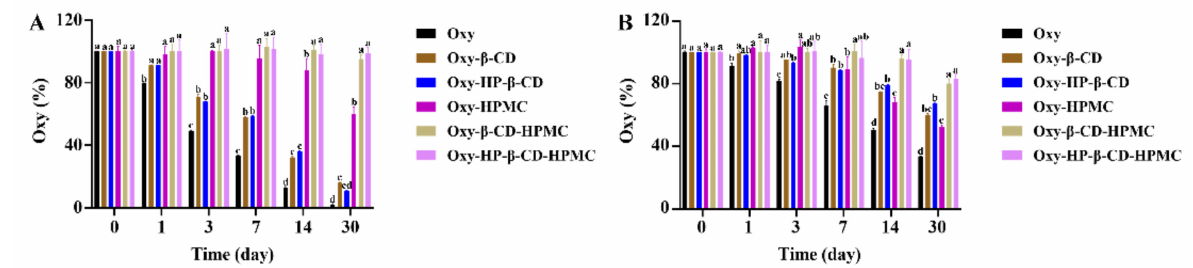
Figure 7. The percentage of remaining Oxy (both trans - and cis -forms) in Oxy, Oxy–HPMC, Oxy–CD, and Oxy–CD–HPMC solutions during 30 days of storage at 5 ◦ C without light was recorded by monitoring Oxy content with HPLC at a certain time interval ( n = 3, if no error bars are displayed, errors were smaller than symbols). Data were presented as mean ± SD, and significant differences compared to the pure Oxy group are shown with lower case letters a–d. All samples were stored in well-closed glass bottles. ( A ) Water; ( B ) acidic solution (pH 3.6). The lack of figures of the trans and cis forms here indicates that no cis -Oxy is formed in this treatment, and all remaining Oxy is in the trans structure.